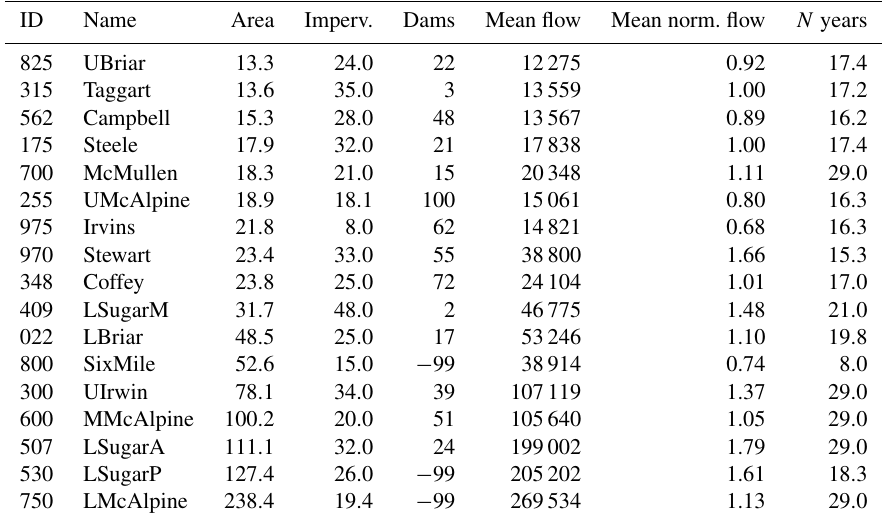
Table 2. Summary of hydrological basins in the Charlotte area: basin area (km 2 ), imperviousness (%), average 24h flow (m 3 ), average 24h flow normalized by basin area (mm) and length of observation in years.